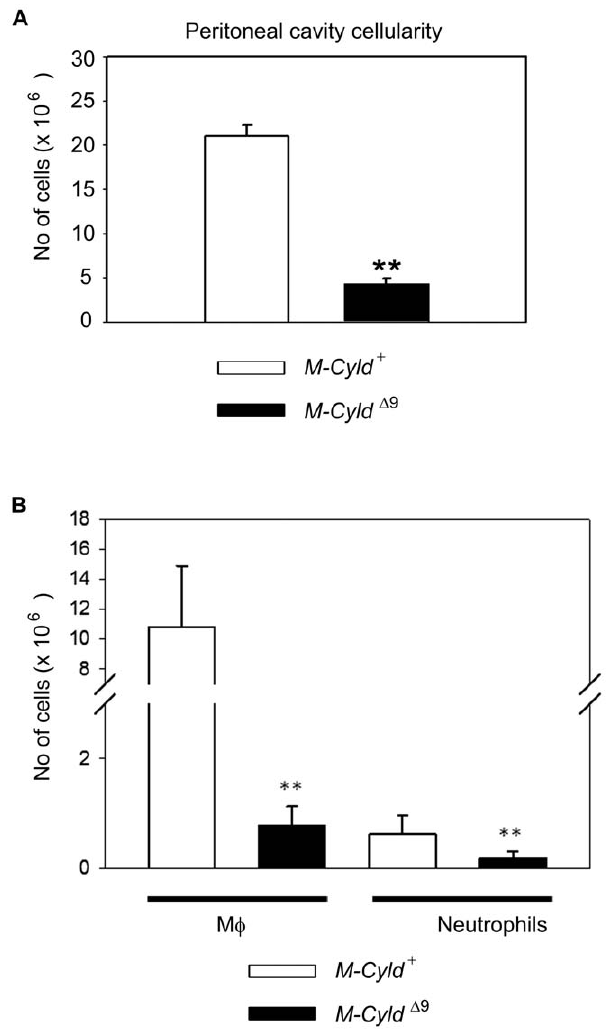
Figure 5. Impaired accumulation of thioglycollate-elicited peritoneal macrophages in M-Cyld D 9 mice. A) Enumeration of cells in the peritoneal cavity fluid that was collected from control ( M-Cyld + ) and mutant ( M-Cyld D 9 ) mice 72 hours after thioglycollate injection. Data are depicted as mean absolute numbers ( 6 SEM) from n=7 control and 7 M-Cyld D 9 mice at 8 weeks of age. The statistically significant difference in peritoneal cavity cellularity between control and mutant mice is depicted by two stars (p=0,0000000064, Student’s unpaired t test). (lower panel). B) Enumeration of macrophages (Mac1 + Gr1 2 ) and neutrophils (Mac1 + Gr1 + ) from control ( M-Cyld + ) and mutant ( M-Cyld D 9 ) mice as assessed by flow cytometric analysis of cells harvested from the inflamed peritoneum 72 hours after thioglycollate injection by means of CD11b and Gr1 expression. Data are depicted as mean absolute numbers ( 6 SEM) from n=7 control and 7 M-Cyld D 9 mice at 8 weeks of age. The statistically significant difference in peritoneal cavity cellularity between control and mutant mice is depicted by two stars (p , 0,01 unpaired t test).